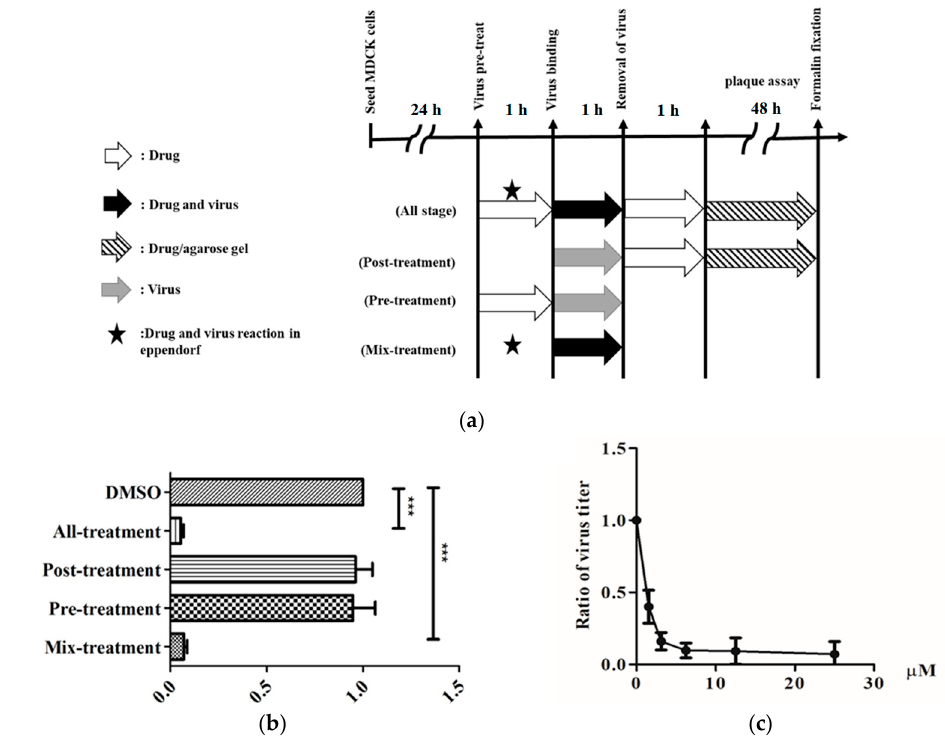
Figure 7. Anti-IAV assay of 1-monopalmitin ( 29 ). ( a ) Schematic representation of the strategies used to test the anti-IAV activity. ( b ) MDCK cells were infected with IAV (A/WSN/1933(H1N1)) and treated with 29 at the concentration of EC 90 at the indicated time according to the different strategy presented above. ( c ) Anti-IAV activities of different concentration of 29 . DMSO was used as a solvent control. The data are presented as mean ± SD of three independent experiments and were normalized to the solvent control data (*** p <